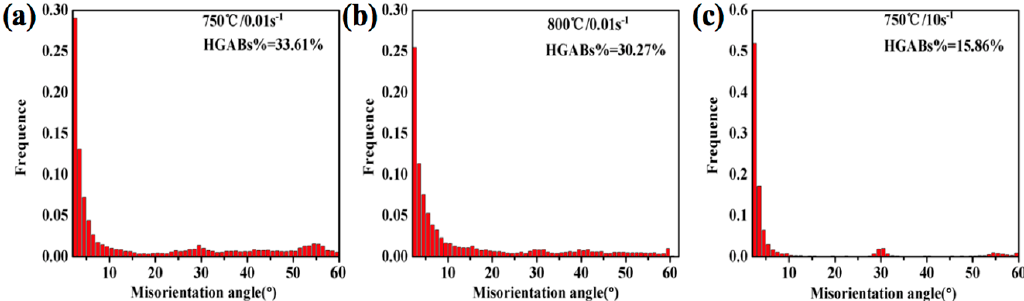
Figure 12. The EBSD analysis results of Ti-35421 alloy deformed at different conditions of α + β phase region: ( a ) 750 °C, 0.01 s − 1 ; ( b ) 800 °C, 0.01 s − 1 ; ( c ) 750 °C, 10 s − 1 .